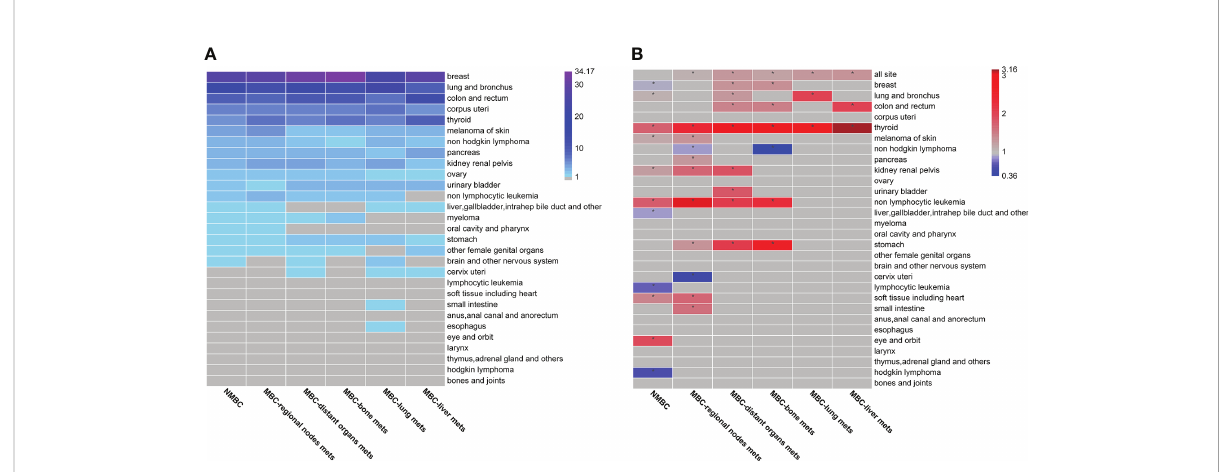
FIGURE 2 The patterns of second primary cancers (SPCs) in Breast cancer (BC) patients with different metastasis status (A) Calculated by dividing the number of SPC cases observed per unit by the total number of SPCs observed. The grey cells indicate tumor types that are less than 1% of the total number of SPCs. Percentage values are shown in Supplementary Table 2. (B) Standard incidence rates (SIRs) are calculated as the ratio of the number of SPCs observed to the number of SPCs expected in the general population. Cells marked with an * symbol show a statistically signi fi cant association between fi rst primary breast cancer (BC) and SPCs. Blue cells indicate SIRs that are statistically signi fi cantly lower than expected according to a qualifying statistical test (number of SPCs observed ≥ 5). Red cells indicate SIRs that are statistically signi fi cantly higher than expected according to a qualifying statistical test (number of SPCs observed ≥ 5). Gray cells indicate SIRs, which are not statistically signi fi cant or associations not tested due to the small number of SPCs observed. Point estimates and 95% CIs are shown in Supplementary Table